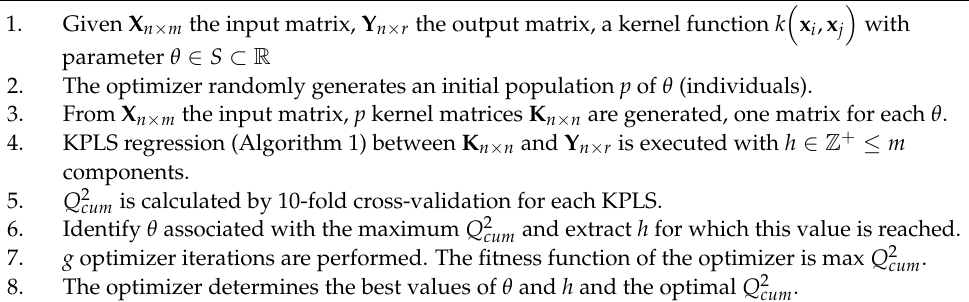
Algorithm 3. KPLS parameters selection